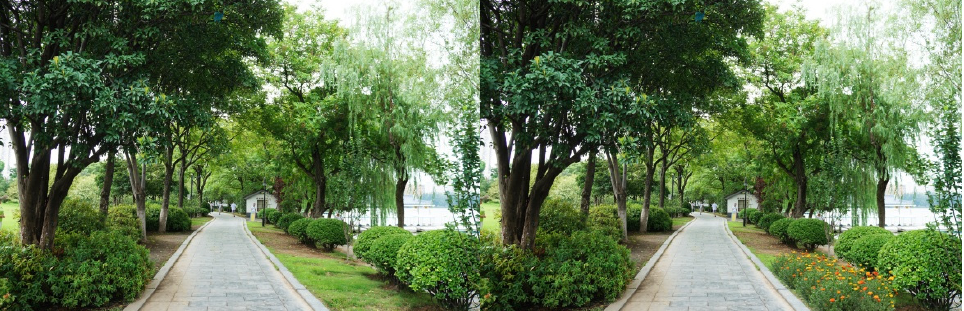
Figure 5. Example: Colorful flowers (herbaceous flowers were